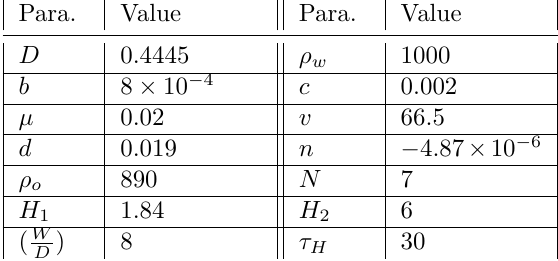
Table 4: Values of drilling parameters in Section